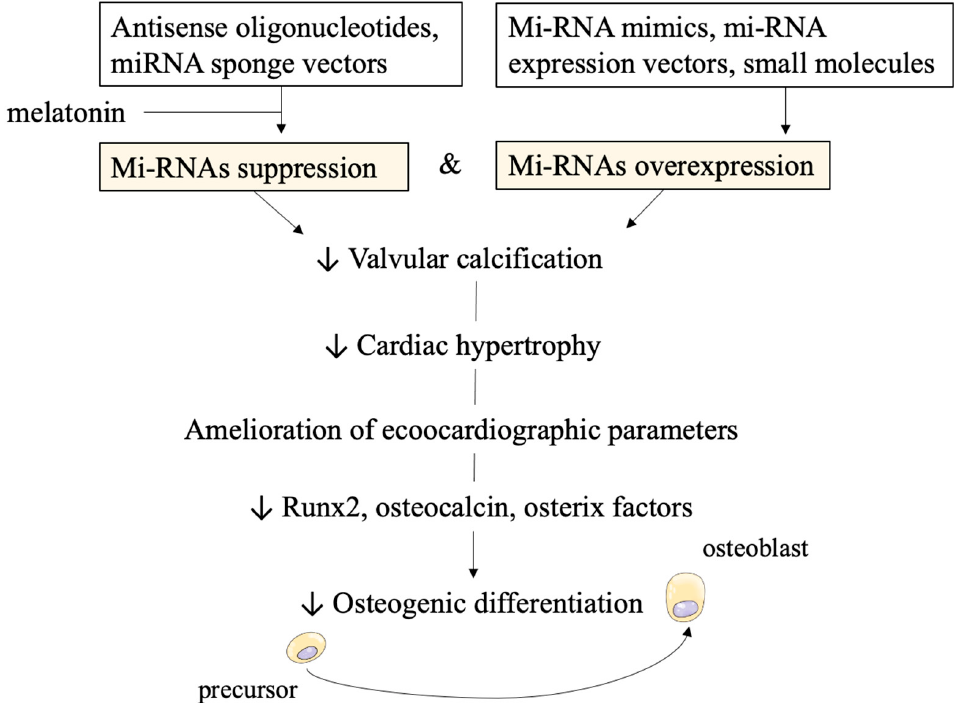
Figure 2. Possible therapeutic strategies and in vitro/in vivo effects of miRNAs targeting. Techno- logical approaches of suppressing and overexpressing miRNAs are displayed at the top of the figure. The subsequent reduction in calcification clinical parameters and molecular pathways is achieved.